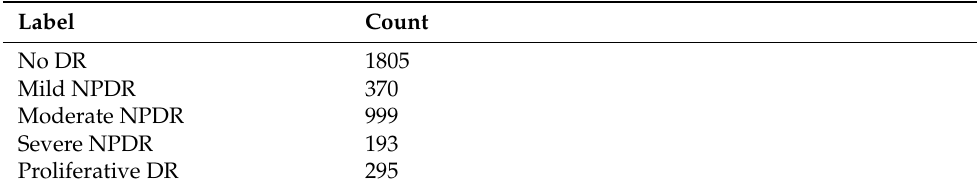
Table 5. Distribution of classes in the APTOS dataset